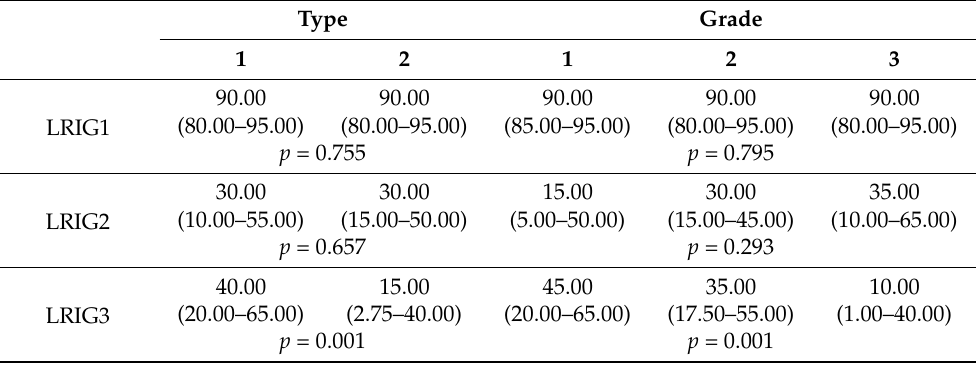
Table 3. Characteristics of the analytical sample at endometrial cancer diagnosis and characteristics of corresponding endometrial cancer biopsies ( n = 75).